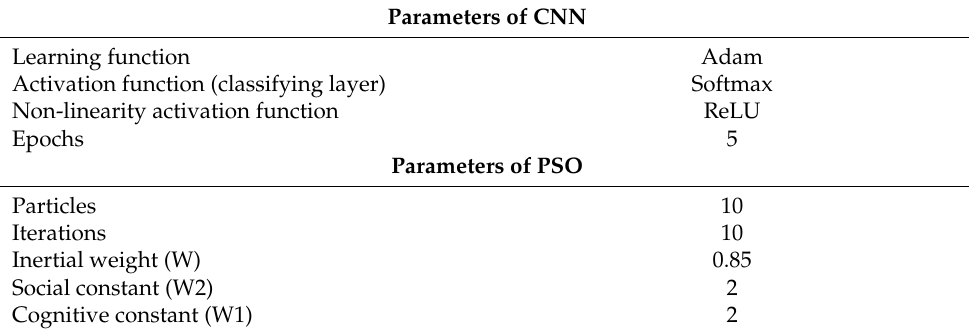
Table 8. Static parameters for CNN and